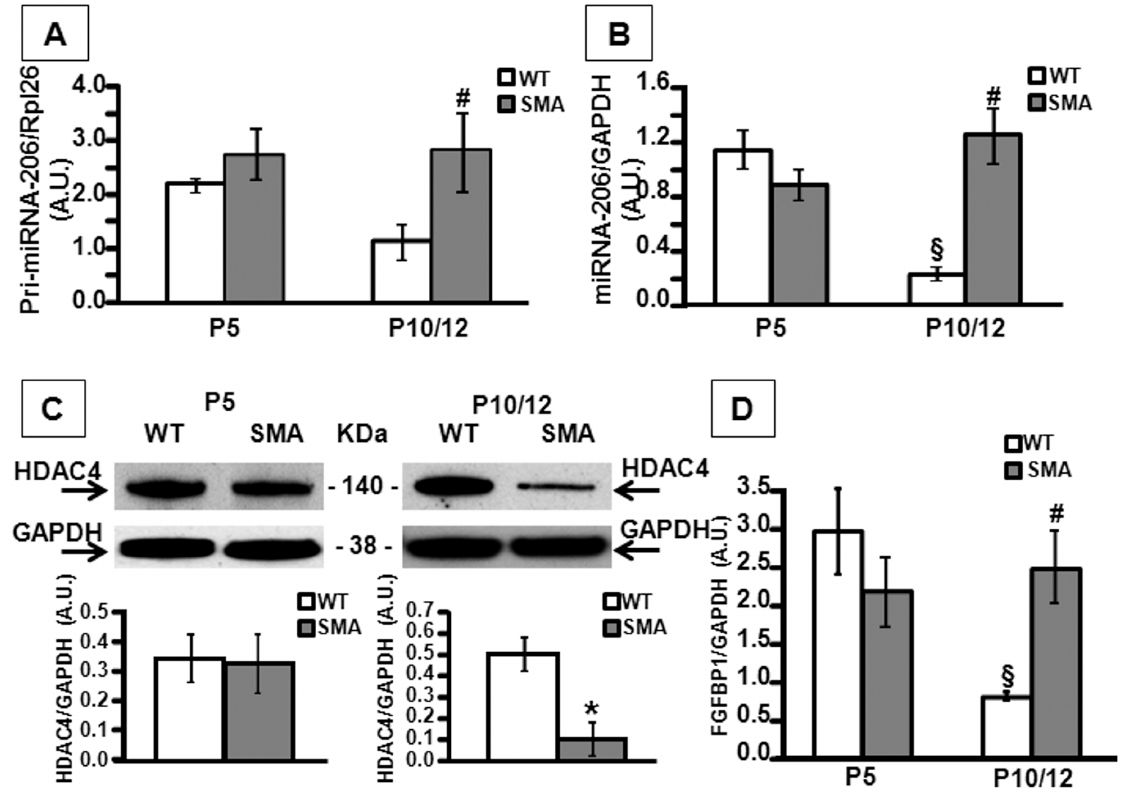
Fig 4. pri-miRNA-206, mature miRNA-206, HDAC4 and FGFBP1 expression levels in quadriceps of WT and SMA mice at P5 and P10/P12. Panels A, B,D, evaluation of pri-miRNA-206 (panel A), mature miRNA-206 (panel B) and FGFBP1 (panel D) mRNA levels in WT and SMA mice, five (P5) and ten (P10/ 12) days after birth. #p < 0.05 vs P10/12 WT, § p < 0.05 vs all group by ANOVA followed by post hoc Newman-Keuls test. Panels C, representative Western blots displaying HDAC4 protein levels in WT and SMA mice, at P5 (left blot) and P10 (right blot). Graphs below each image report the quantification of HDAC4/GAPDH protein levels. * p < 0.05 vs WT by t-test